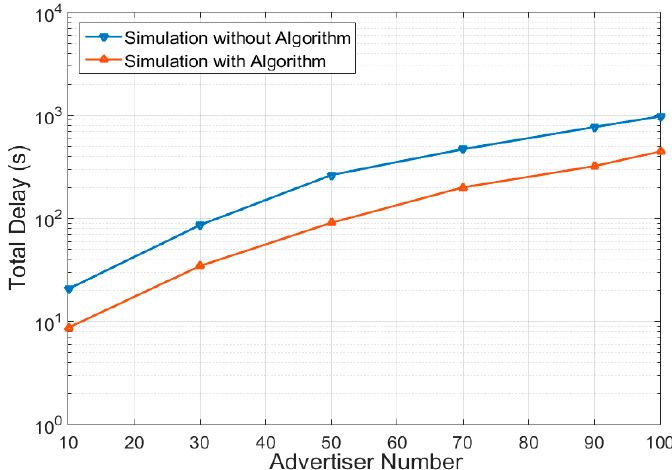
Figure 13. Total delay for advertiser discovery by the initiator in the worst-case scenario.